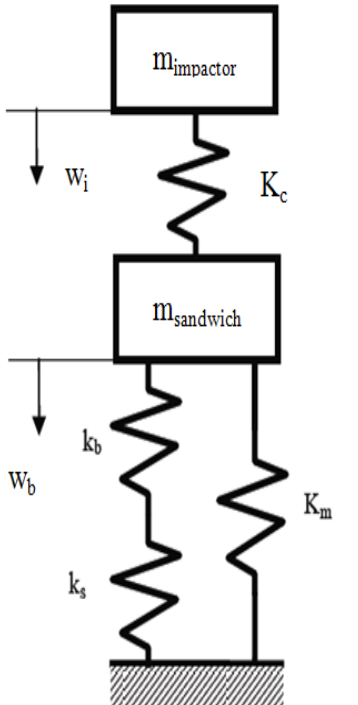
Figure 13. Spring-mass model for impact